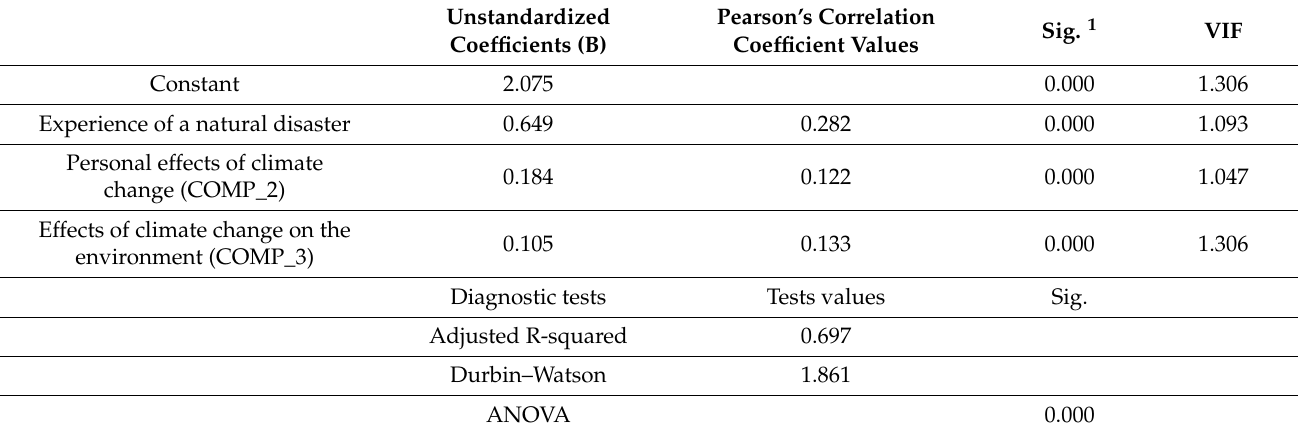
Table 9. Multiple linear regression model for the risk perceptions of climate change analysis, coefficients and diagnostic